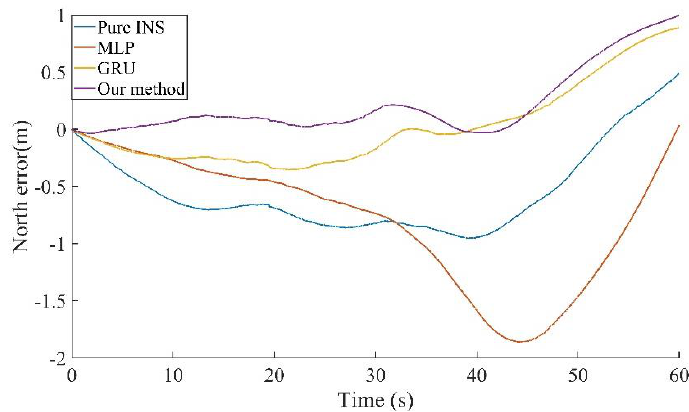
Figure 9. The north position error result of 60 s outage of Experiment 1.